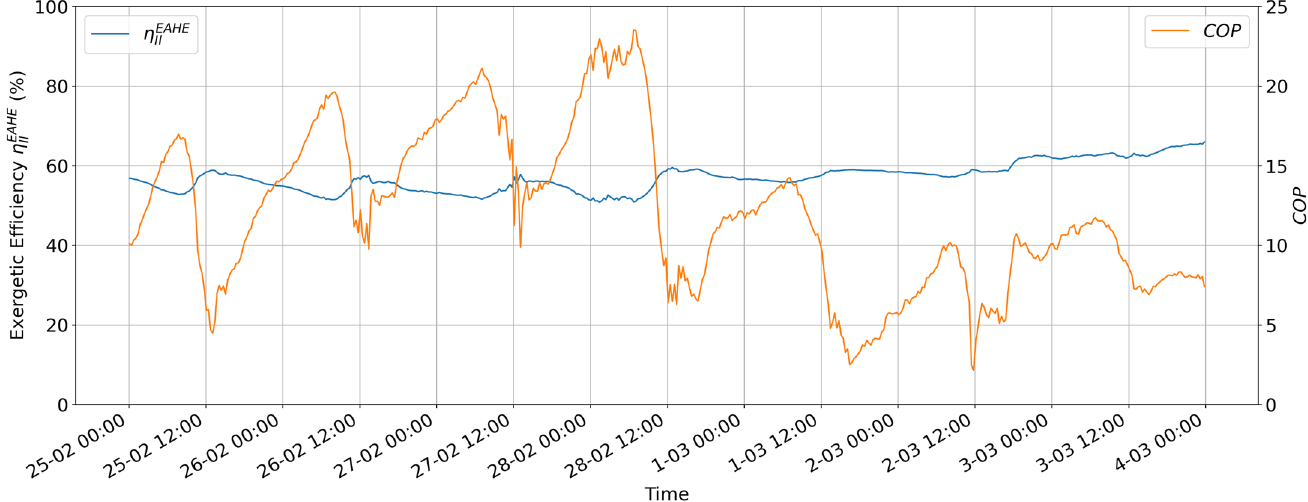
Figure 8. Performance assessment of the EAHE showing the variation in the COP and the exergetic efficiency of the system during the coldest week of 2018. efficiency of the system during the coldest week of